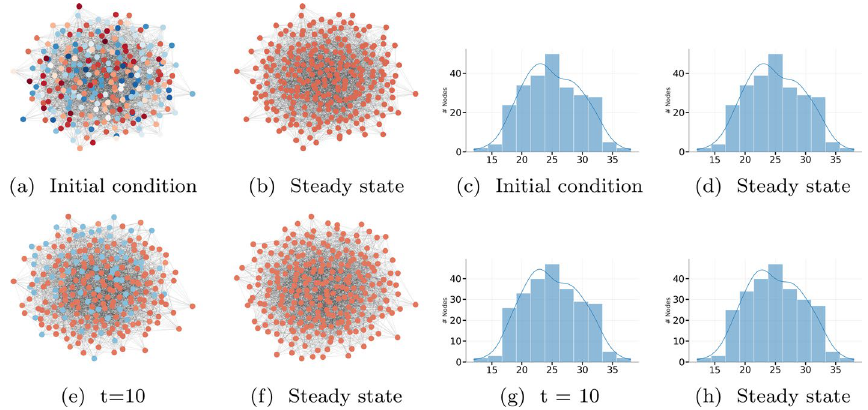
Fig. 11 Example of the effects of the adaptive topology on the Algorithmic Bias Model on Simplicial Complexes on the Erdős–Rényi graph An example of the effects of the adaptive topology on the Algorithmic Bias Model on Simplicial Complexes on the Erdős–Rényi graph for ǫ = 0.2 , p r ∈ { 0.0,0.5 } and γ = 0.5 .